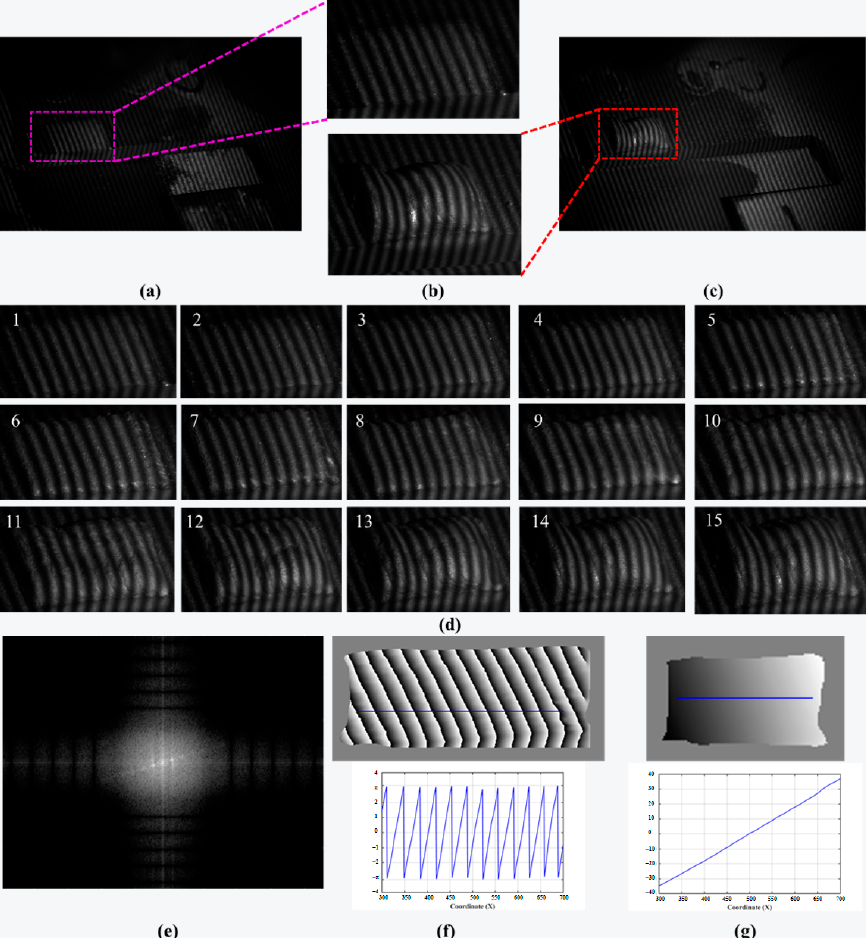
Figure 12. Deformation fringe pattern taken during additive manufacturing of metal parts (taken by the left camera). ( a ) deformation fringe of the first printed layer; ( b ) comparison of fringe changes of metal parts after printing the 1st and 15th layers; ( c ) deformed fringe image of 15th printed layers; ( d ) deformed fringe images of different layers; ( e ) Fourier spectrum of the dashed region of the ( a ); ( f ) wrapped phase of ( e ); ( g ) unwrapping phase of ( f